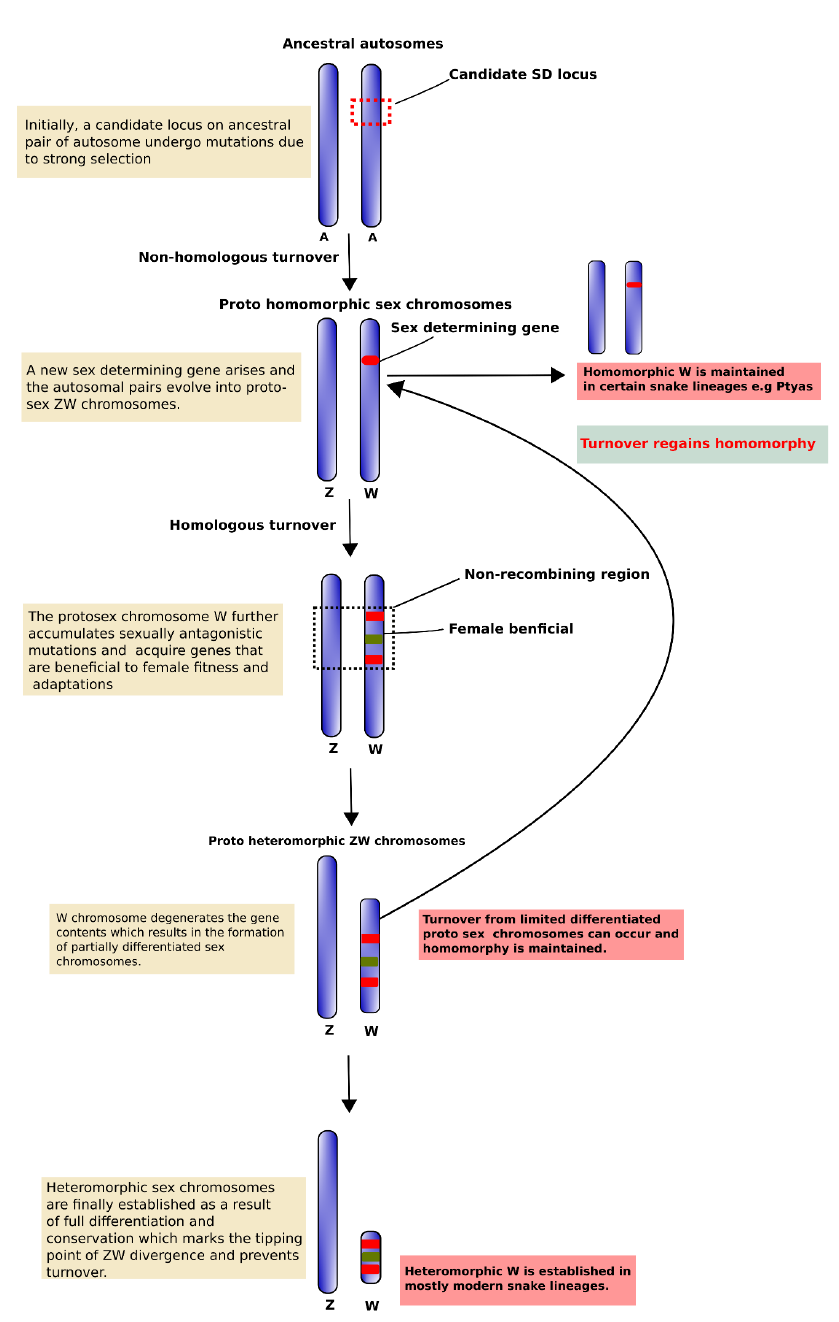
Figure 1. Schematic diagram of di ff erent phases in ZW sex chromosome evolution. We propose